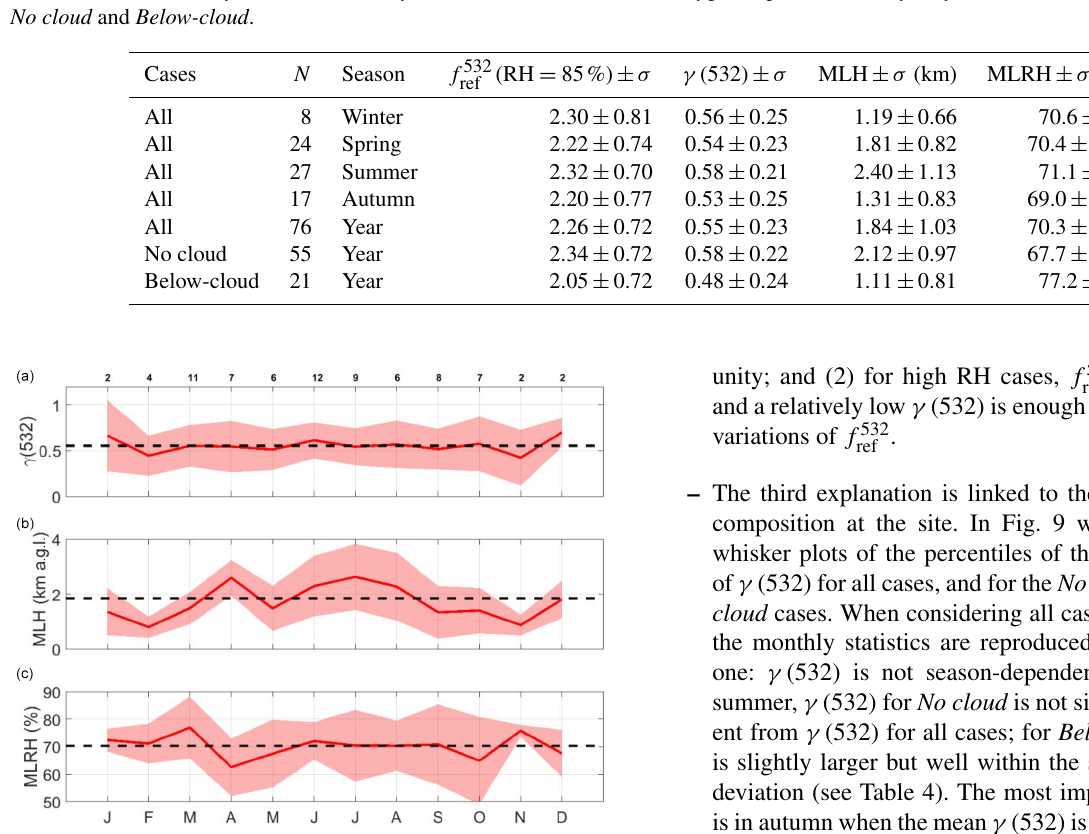
Figure 7. Monthly (a) hygroscopic growth parameter at 532nm, γ (532); (b) mean-layer height (MLH); (c) mean-layer relative hu- midity (MLRH). The red shaded area represents the standard devi- ation. The yearly average is represented with a black dash line. The numbers above the top plot are the number of hygroscopic cases per